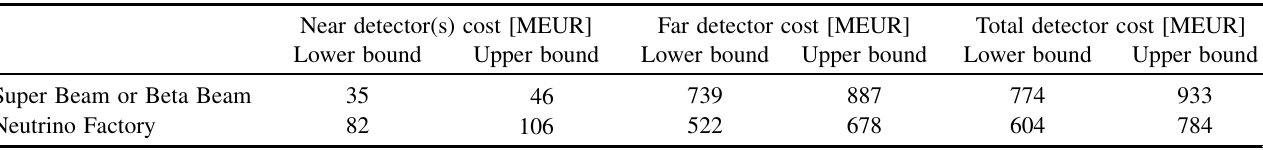
TABLE II. Total cost of the near and far detectors. The near and far detectors are the same for the Super Beam and Beta Beam. If both facilities operated simultaneously, two near detectors would be required, but only one far detector. The near detector cost for a Neutrino Factory is for two detectors.